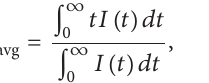
Figure 3: The emission spectra of the Eu 3+ activated Mg 2 TiO 4 nanoparticles prepared at different temperatures from 400 ∘ C to 650 ∘ C.